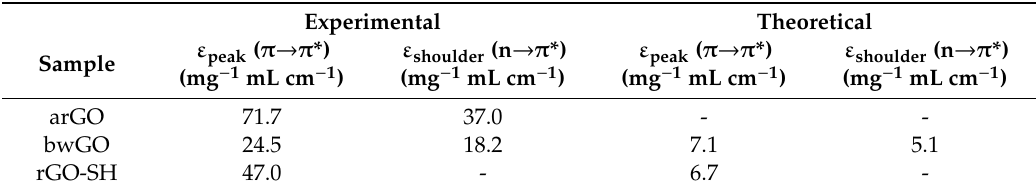
Table 1. Calculated molar extinction coe ffi cients from the experimental UV-visible spectra of as-received GO (140 × 10 − 3 mg / mL in water), base-washed GO (20 × 10 − 3 mg / mL in water), and thiolated reduced GO (10 × 10 − 3 mg / mL in DMSO) and from the computational